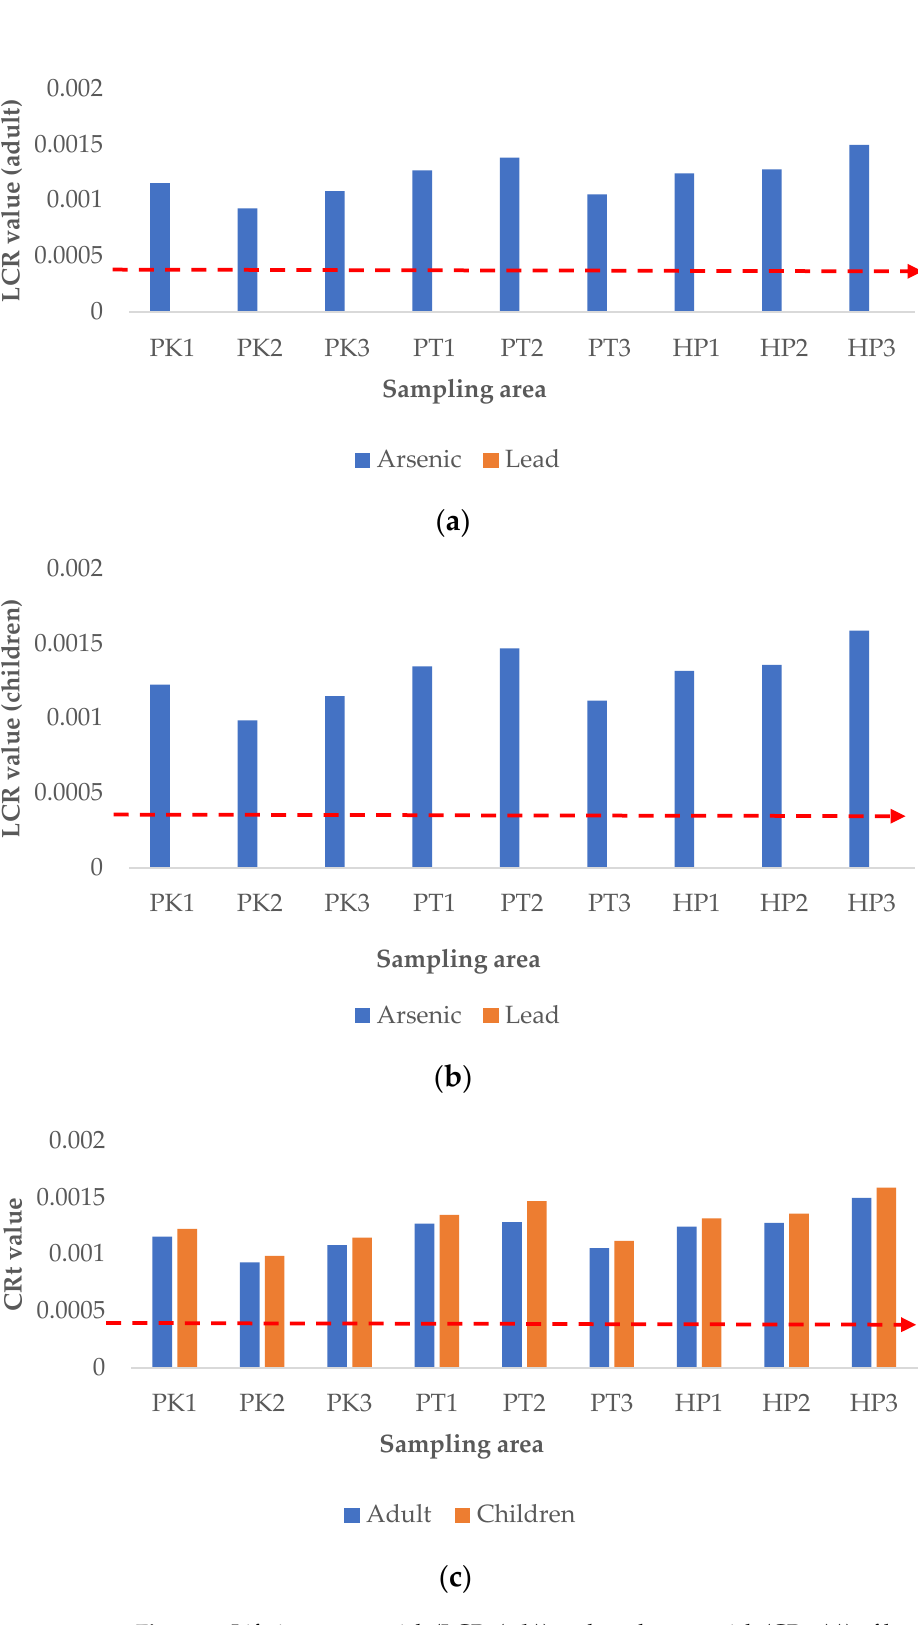
Figure 5. Lifetime cancer risk (LCR, ( a , b )) and total cancer risk (CRt, ( c )) of heavy metals for adults and children through rice consumption. P1K, Plot 1 Kerian; P2K, Plot 2 Kerian; P3K, Plot 3 Kerian; P1PT; lot 1 Perak Tengah; P2PT, Plot 2 Perak Tengah; P3PT, Plot 3 Perak Tengah; P3PT, Plot 3 Perak Tengah; P1HP, Plot 1 Hilir Perak; P2HP, Plot 2 Hilir Perak; P3HP, Plot 3 Hilir Perak.